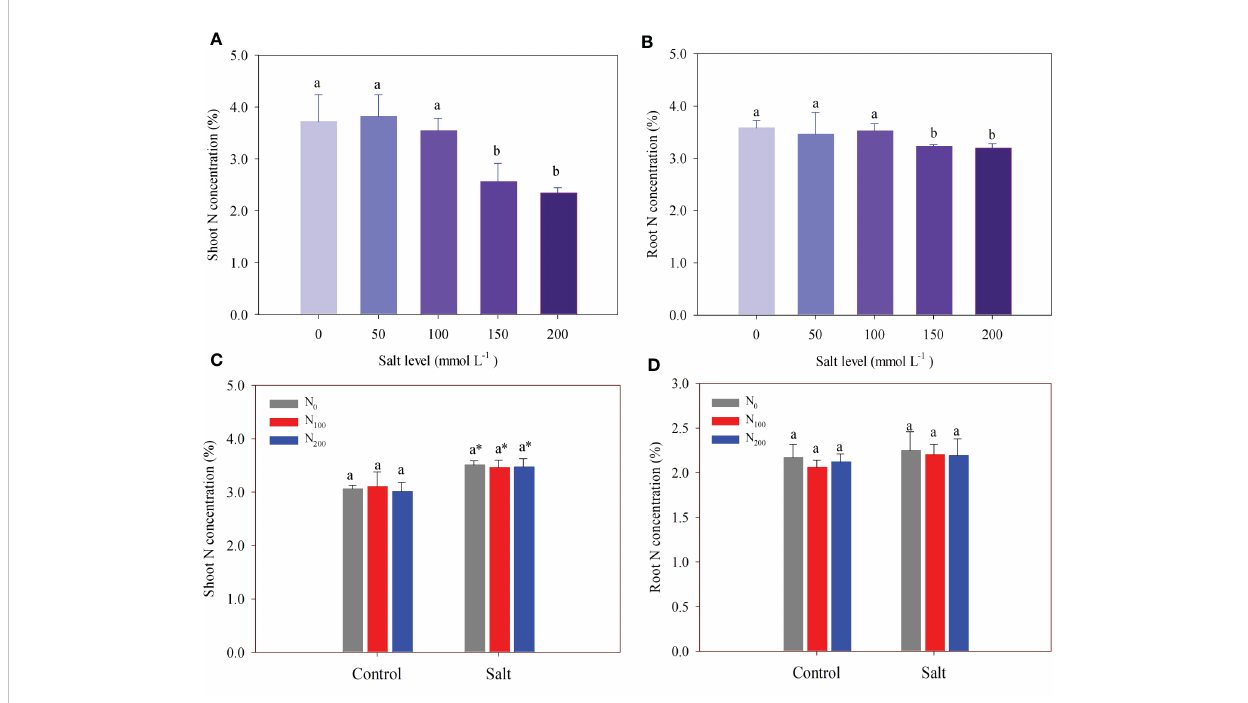
FIGURE 3 Alfalfa shoot (A) and root (B) nitrogen (N) concentration in different salt levels in experiment 1. Alfalfa shoot (C) and root (D) N concentration in different N supply and salt levels in experiment 2. Error bars represent ± SD of the mean. Different letters represent a signi fi cant difference among treatments ( p ≤ 0.05). Asterisks refer to signi fi cant differences between salt levels at the same N fertilizer supply